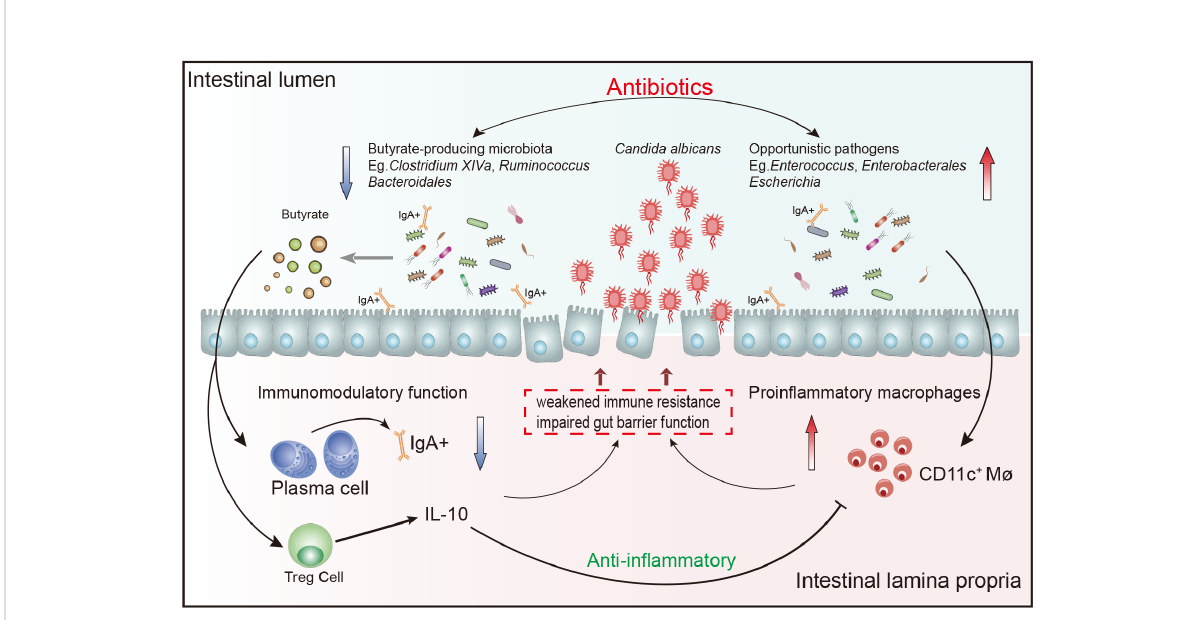
FIGURE 7 Schematic drawing showing relationship between the intestinal microbiome and immune